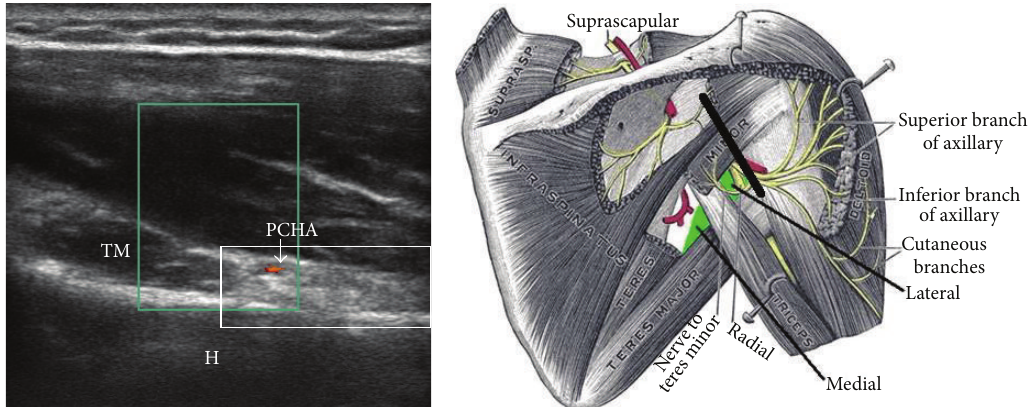
Figure 3: View of the quadrilateral space (white box), posterior circumflex humeral artery (PCHA), humerus (H), and teres minor (TM). Figure adapted from the medical gallery of Mikael